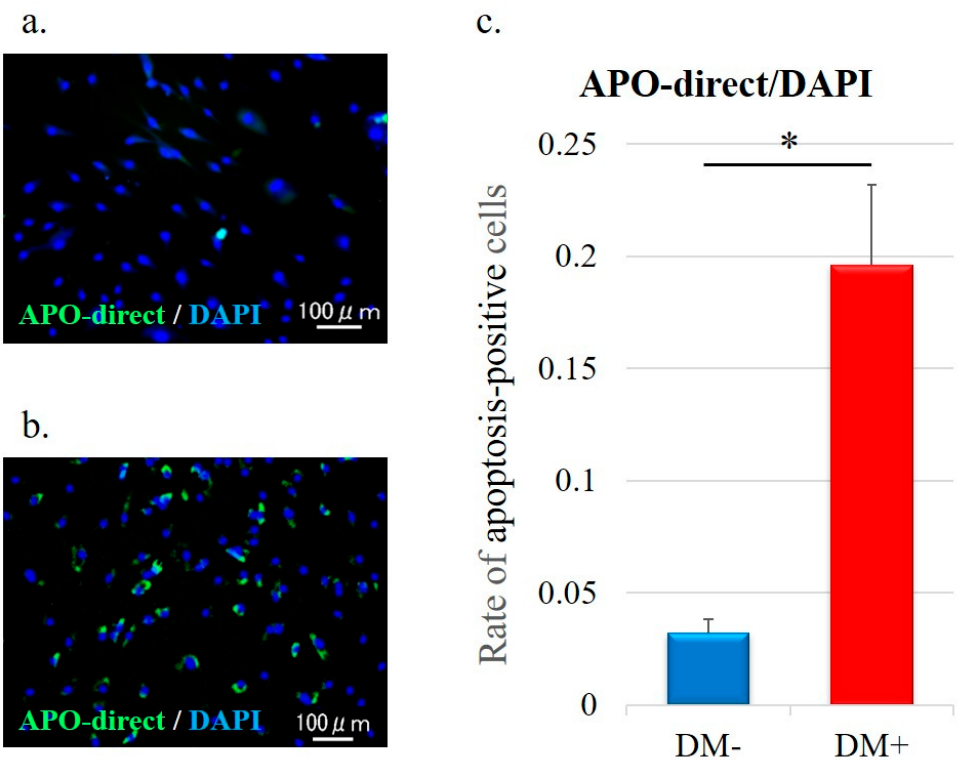
Figure 5. Representative immunofluorescence images of nuclear fragmentation (suggestive of apoptosis) in rotator-cuff-derived cells: ( a ) non-diabetic controls and ( b ) diabetic group. The TUNEL staining (green) highlights the apoptotic cells in each group. ( c ) Relative quantification of apoptotic cells. The number of apoptotic cells was analyzed by fluorescence intensity normalized to cell number. Apoptosis-positive cells and DAPI-positive cells in four rectangular areas (0.75 mm × 1.0 mm) on each slide were counted and their mean values were analyzed. The apoptosis-positive cells rate (number of apoptosis-positive nuclei/DAPI-positive nuclei) is given as the mean of the four areas. Data are presented as the mean ± SD. The independent t -test was performed for determining significant differences: * p < 0.001.